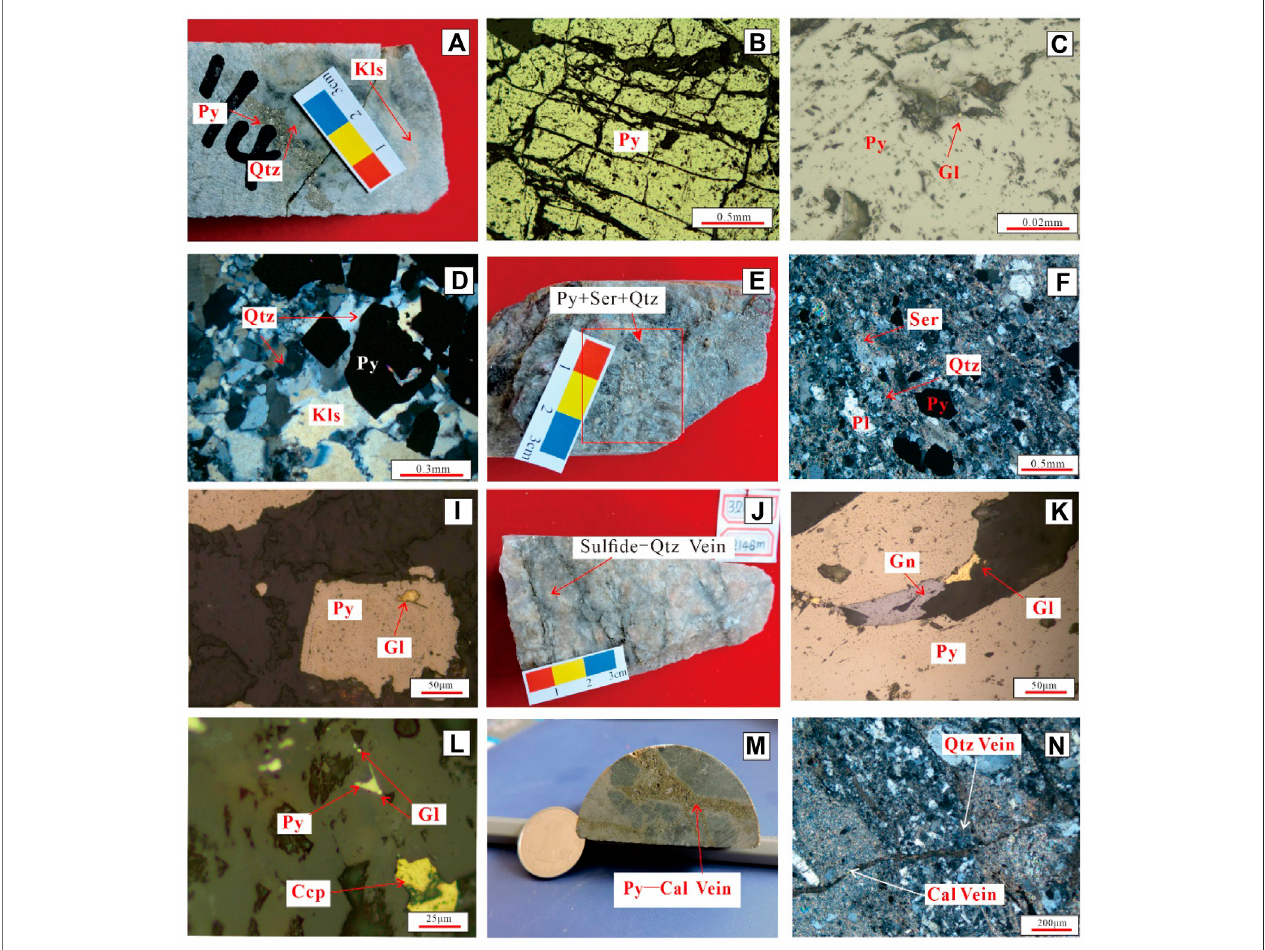
FIGURE 5 | Photos/photomicrographs of rocks and ores from the different mineralization stages of the Zhaoxian gold deposit [hand-specimen (A,E,H,J,M) ; transmitted light (D,F,L,N) and re fl ected-light (B,C,G,H,J,L) ]: (A) stage I pyrite aggregate; (B) stage I broken pyrite; (C) gold included in stage I pyrite; (D) quartz, K-feldspar(altered),andpyrite; (E – F) beresitizationwith fi nemineralgrains; (I) goldincludedinstageIIpyrite; (J) quartz-polymetallicsul fi deveincutdisseminatedore; (K) gold exists in fi ssure; (L) polymetallic sul fi des coexist with gold inclusions; (M) coarse-grained stage IV pyrite-carbonate veins; (N) stage IV quartz and carbonate veins. Py- Pyrite; Qtz- Quartz; Kfs- K-feldspar; Gl-native gold; Ser- Sericite; Pl- Plagioclase; Gn- Galena; Ccp-Chalcopyrite; Cal- Calcite.